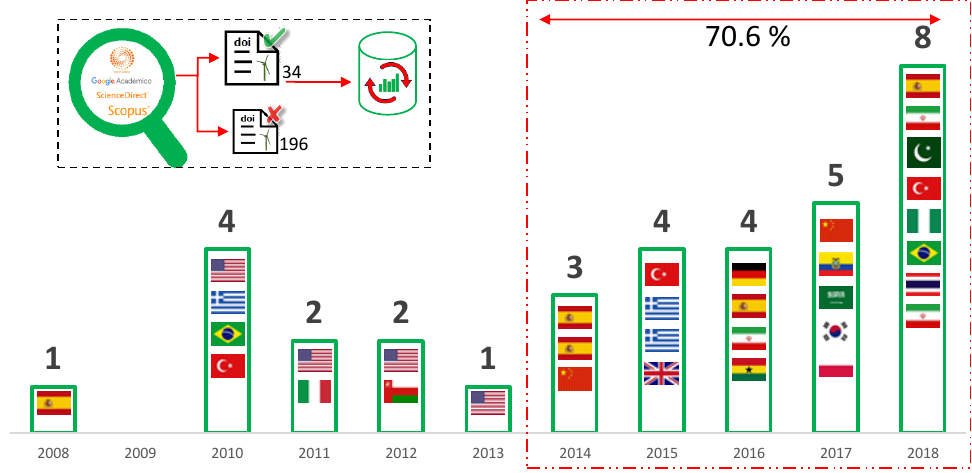
Figure 3. Onshore wind power plant optimal location. Frequency of publications (2008–2018).